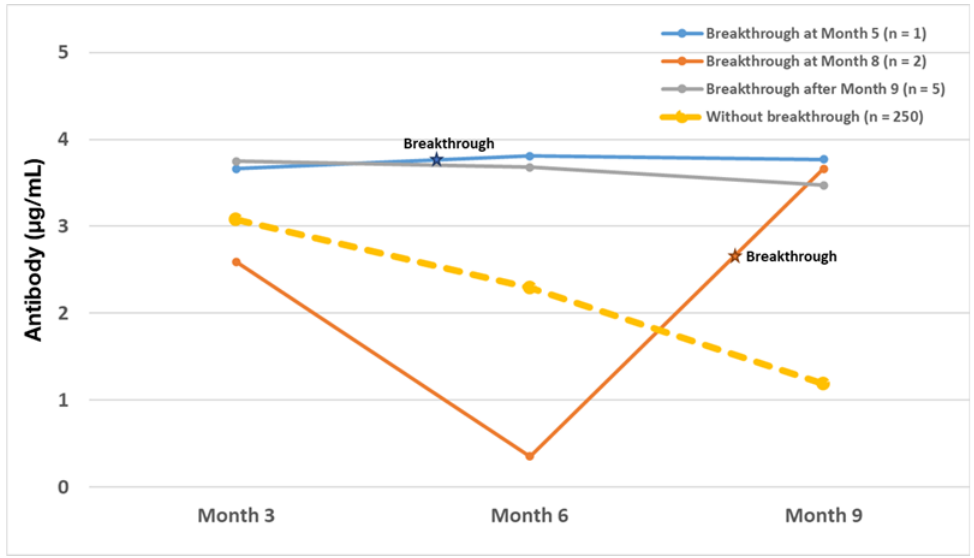
Figure 5. Antibody Titers in Breakthrough Subjects who had Subsequent Antibody Titer Determi- nations. Median antibody levels (µg/mL) for subjects without breakthrough infection after the 2nd vaccination (n = 250), subjects with breakthrough infection after Month 9 (n = 5), subjects with breakthrough infection at Month 8 (n = 2), and subjects with breakthrough infection at Month 5.